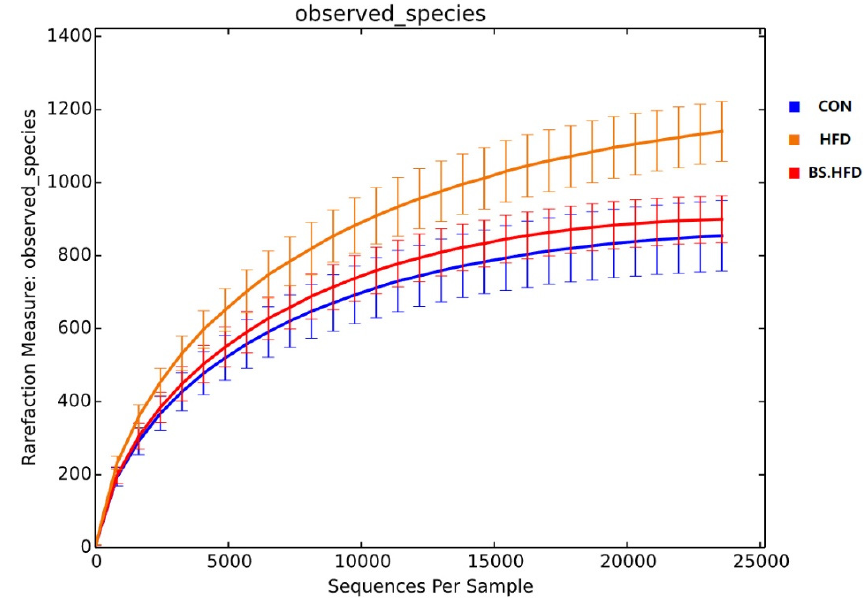
Figure 2. Rarefaction curve of the intestinal microbiota in C. idella .